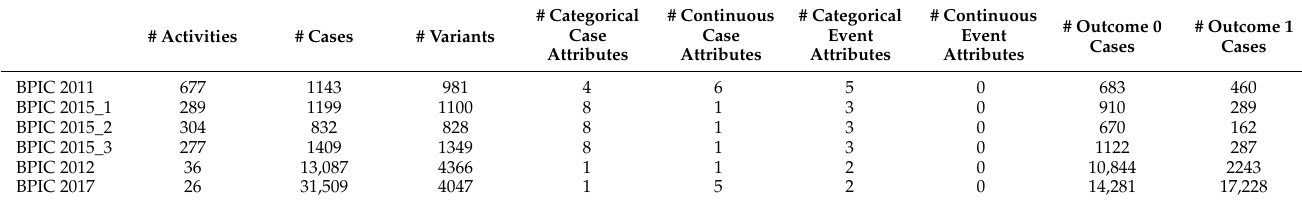
Table 1. Descriptive statistics of event logs used for